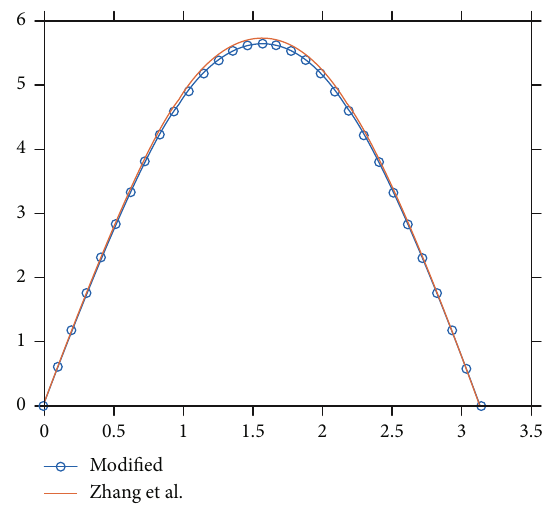
Figure 12: The variations of the system of equations (38) and the solution of the regularized system of equations (12) – (15) for p = 2 , k = 0 : 001 , α = 0 : 05 , and y = 1